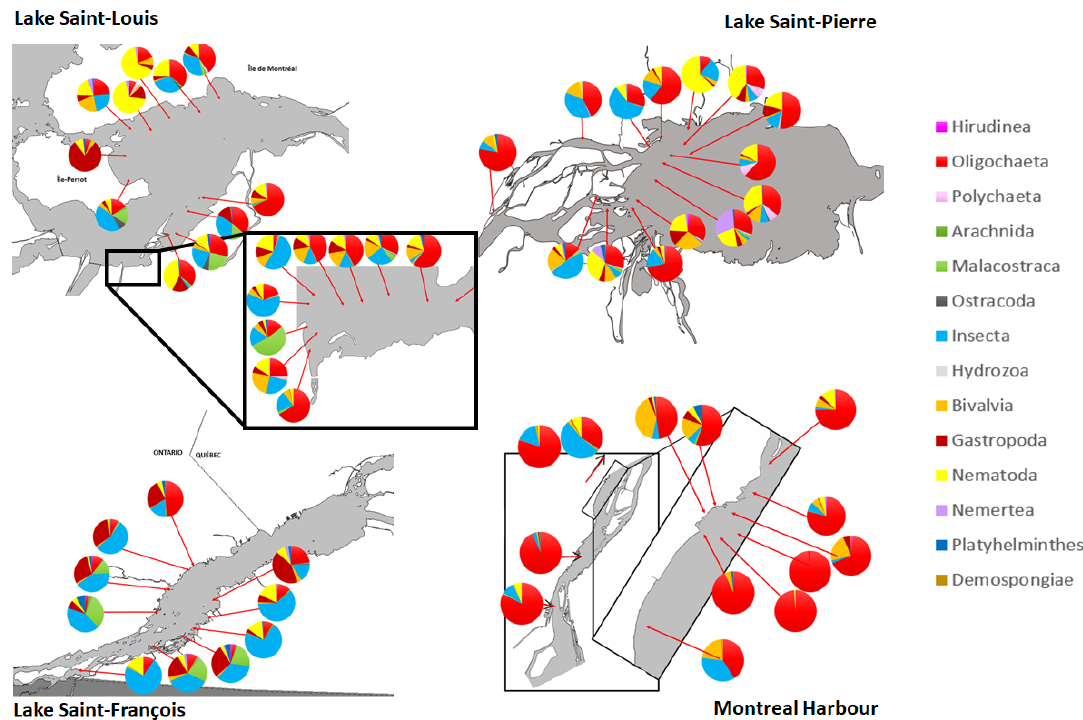
Figure 2. Relative abundance of macroinvertebrate communities in three fluvial lakes and the Montreal harbour along the fluvial section of the St. Lawrence River.